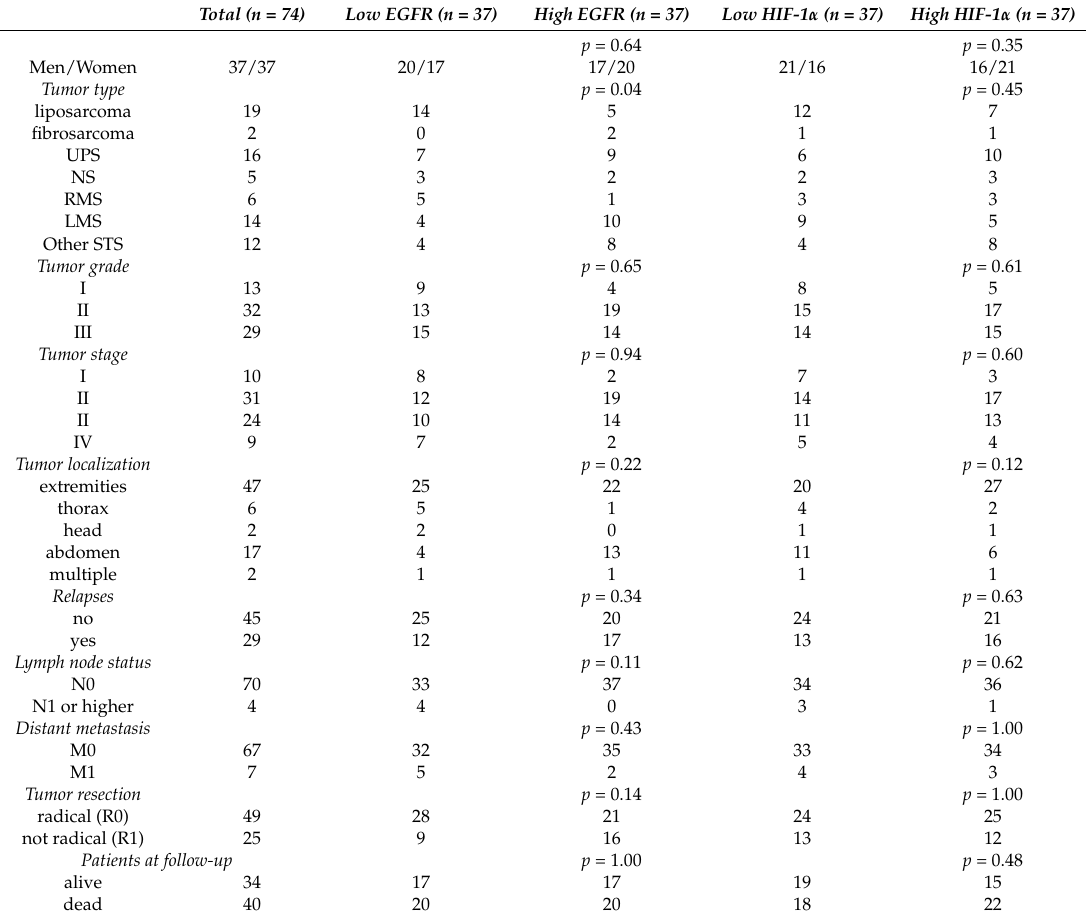
Table 2. Histopathological, clinical, and protein expression